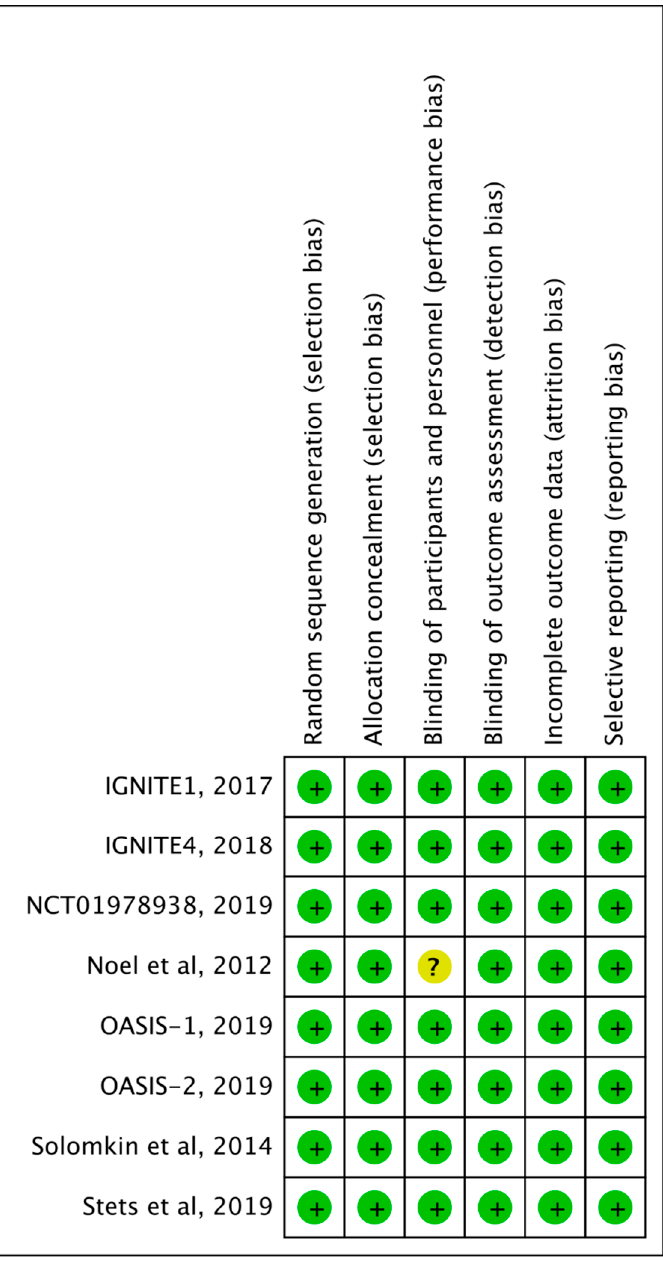
Figure 2. Risk of bias summary.